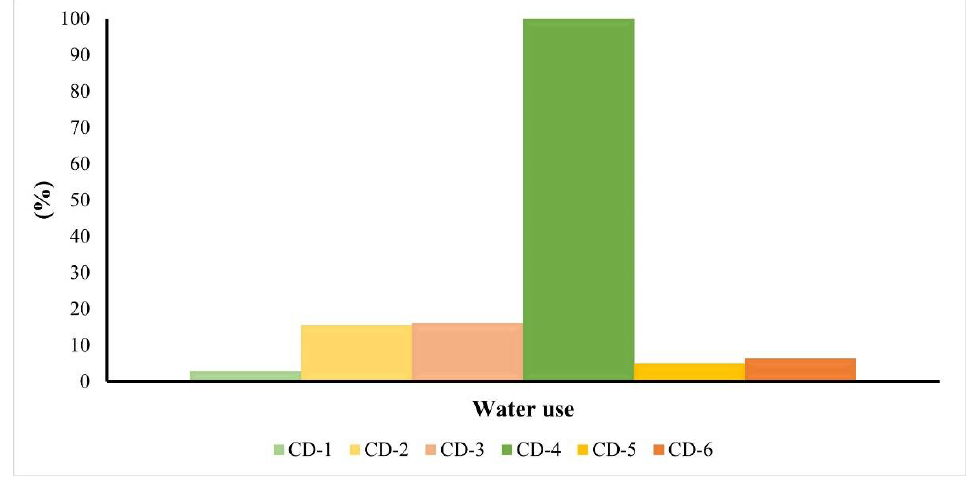
Figure 10. Relative environmental impacts of all the syntheses under study for incineration disposal scenario, applying AWARE method. Green scale refers to hydrothermal treatments; Yellow scale refers to microwave-assisted treatments; Orange scale refers to calcination treatments.